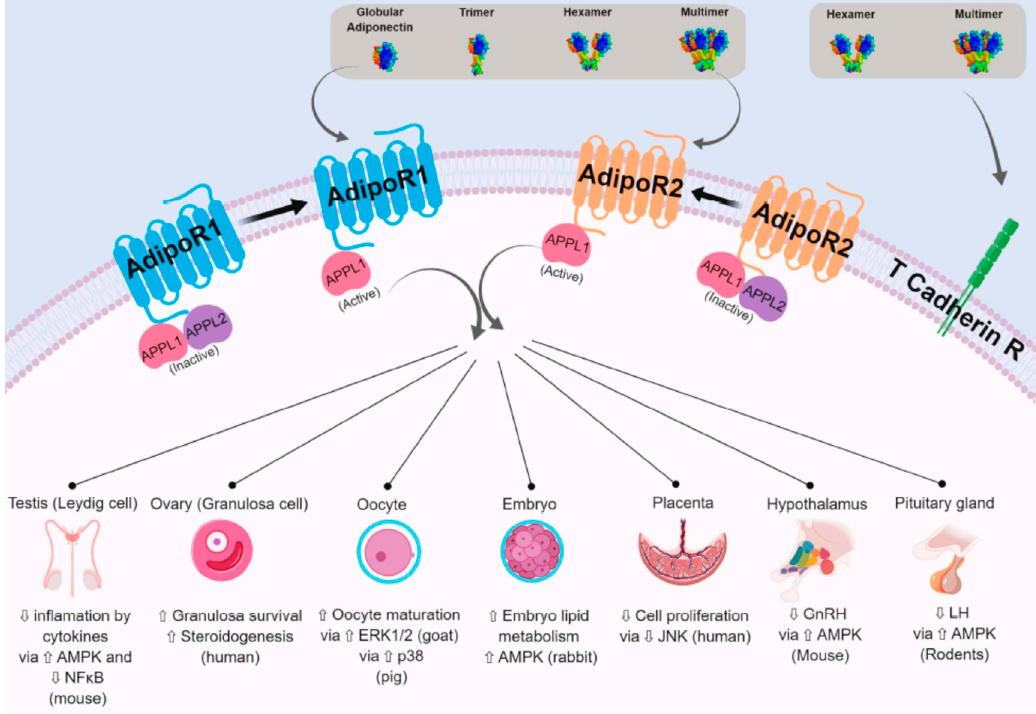
Figure 3. Adiponectin receptors and some examples of biological effects of adiponectin in reproductive tissues or cells. Adiponectin interacts with adiponectin receptors (mainly AdipoR1 and AdipoR2) to activate or inhibit a number of signalling pathways. T Cadherin receptor (T Cadherin R) binds the hexameric and high molecular weight isoforms of adiponectin but it has no intracellular domain. AdipoR1- and R2-dependent signalling is mediated through APPL 1 and APPL2. In the absence of adiponectin signal, APPL2 can bind to the N-terminal domain of the adiponectin receptors